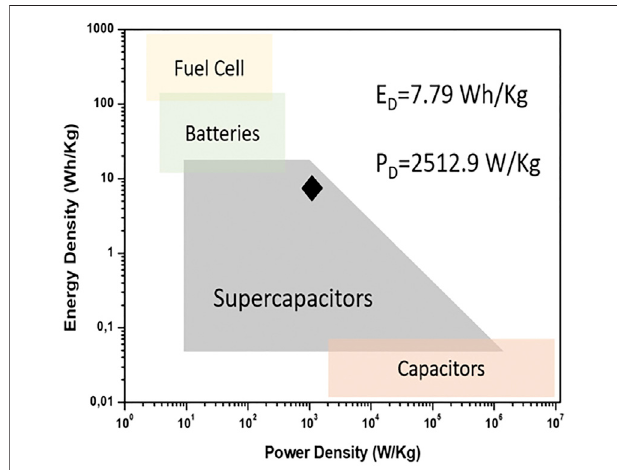
FIGURE 8 | Ragone Plot for the proposed supercapacitor device based on rGO/AuNPs.